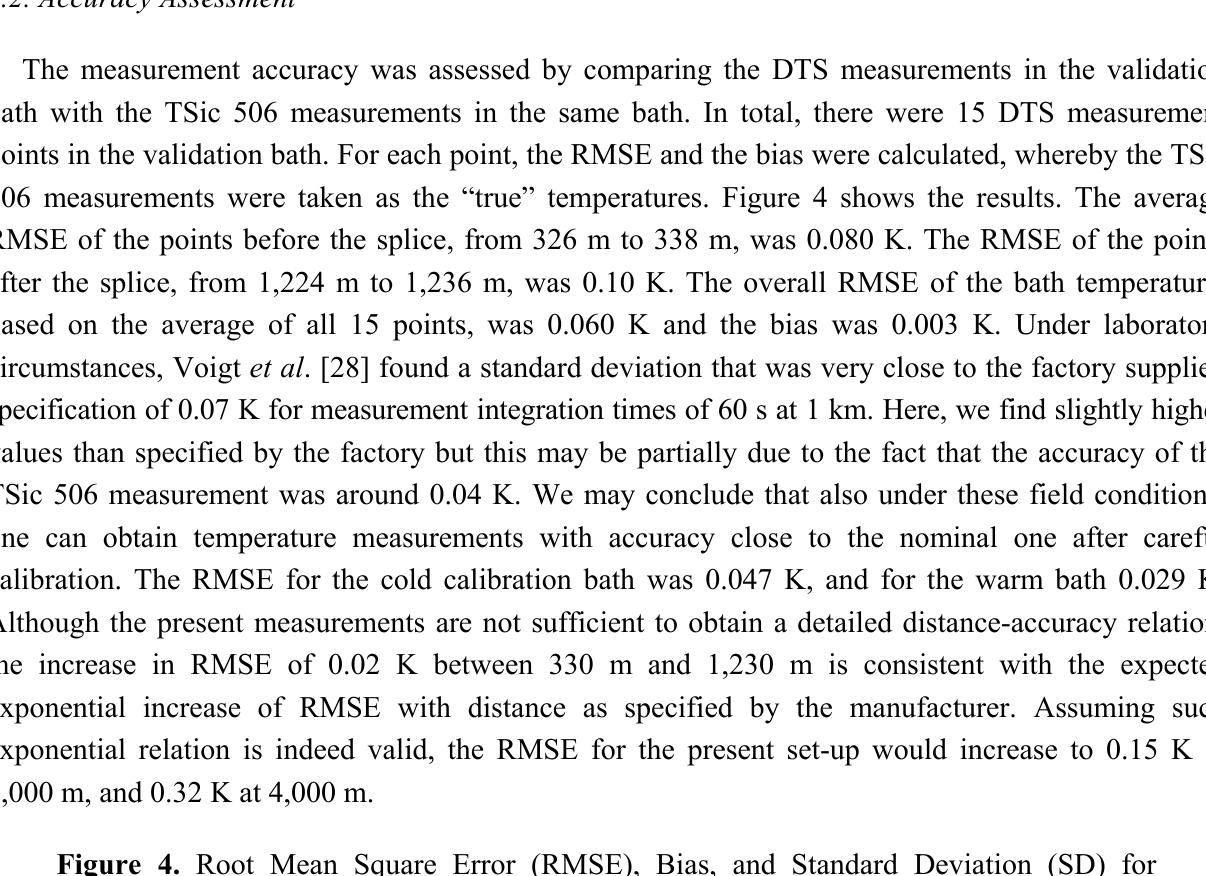
Figure 4. Root Mean Square Error (RMSE), Bias, and Standard Deviation (SD) for measurements in validation bath. The dotted line separates points before and after the splice at the end of the